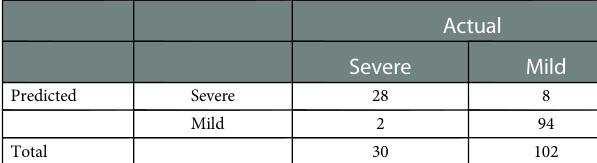
TABLE 1 Admission characteristics of the children in the retrospective cohorts. Values are presented as mean±SD. Characteristic